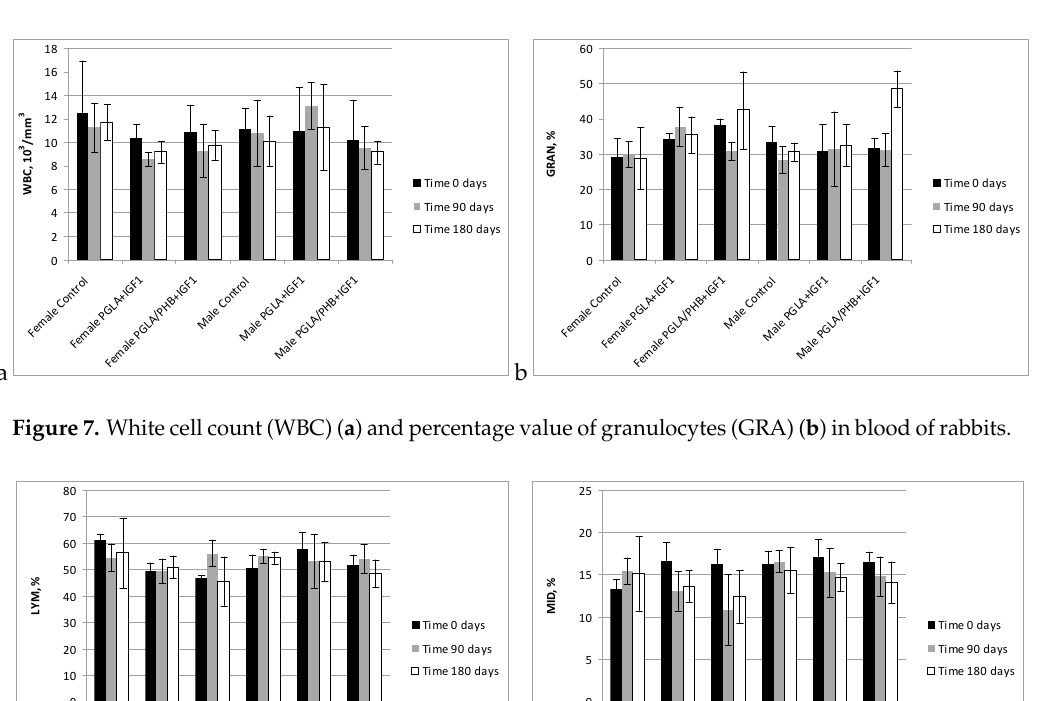
Figure 6. Haemoglobin concentration (HGB) ( a ) and value of haematocrit (HCT) ( b ) in blood of rabbits.